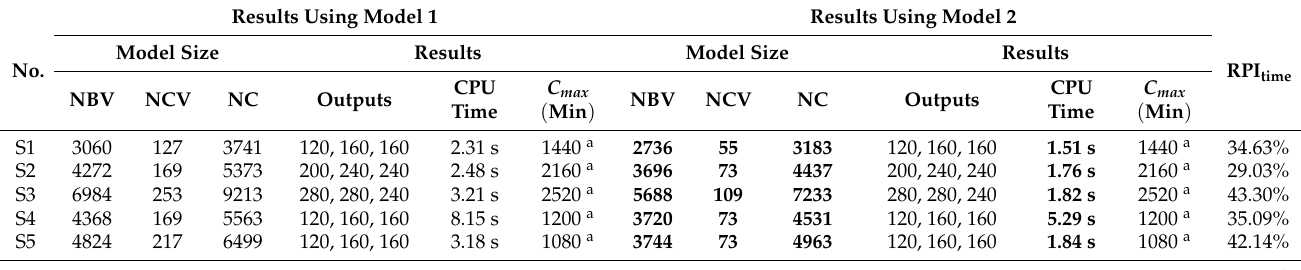
Table 10. Computational results of the small problems using Model 1 and Model